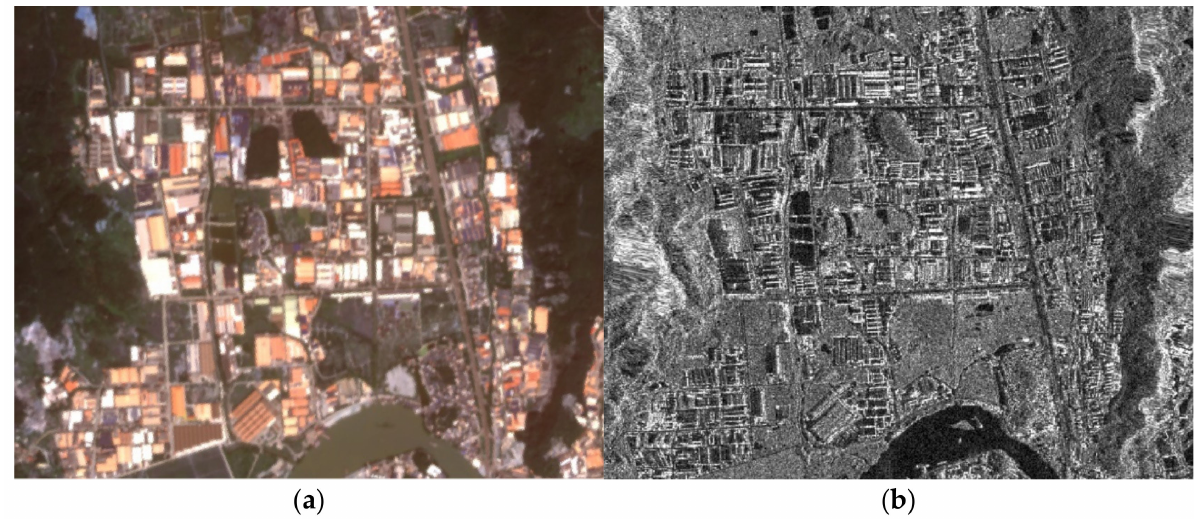
Figure 1. A typical optical satellite image ( a ) and its corresponding SAR image ( b ) of the same